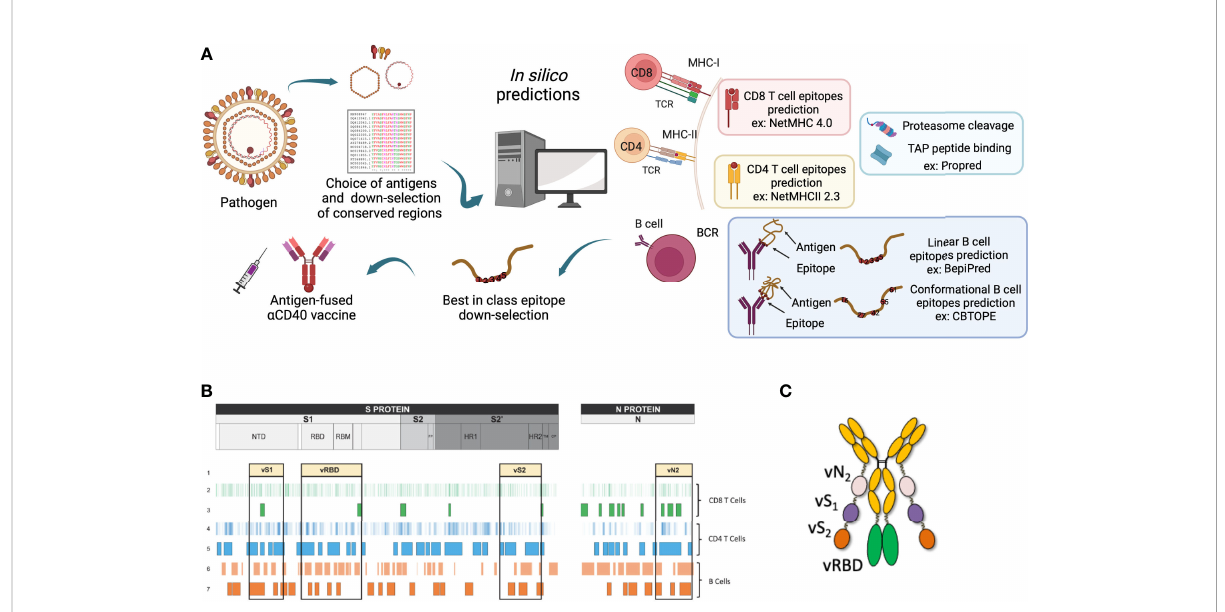
FIGURE 3 Epitope mapping for the selection of the best-in-class DC-targeting vaccine. (A) Viral antigens are chosen depending on current bibliography and what was described at the time of vaccine region selection. This choice takes into consideration the conservation between the different existing viral strains. Selected antigens then undergo in silico predictions using corresponding tools. This fi gure represents MHC-I and -II for CD8 + and CD4 + T-cell epitopes respectively, proteasome cleavage and TAP peptide binding, linear and conformational B-cell predictions examples. This image was created by BioRender software. (B) Example of the design of the Pan sarbecovirus anti-CD40 targeted vaccine after epitope mapping strategy. (C) CD40.CoV-2 vaccine construct, adapted from